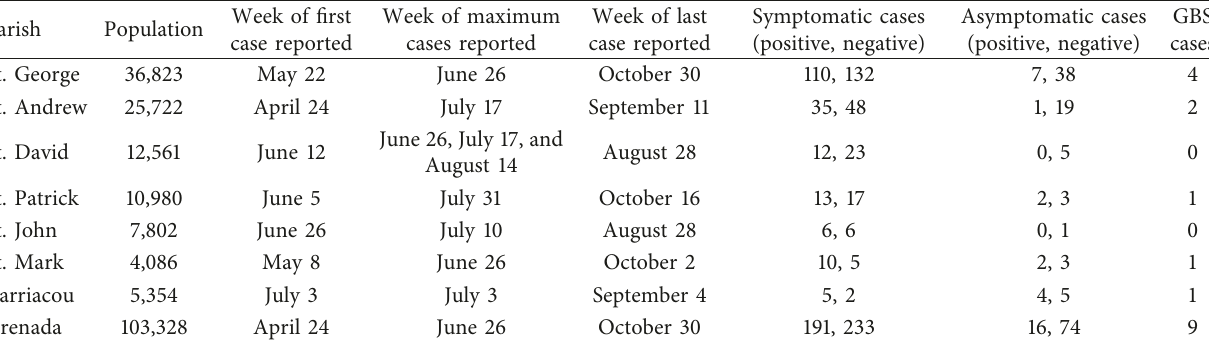
Table 1: Summary of the spatial and temporal distribution of cases by parish during the 2016 Zika outbreak in Grenada showing the first reported case in St. Andrew Parish in the week of April 24 and the last reported case in St. George Parish in the week of October 30.